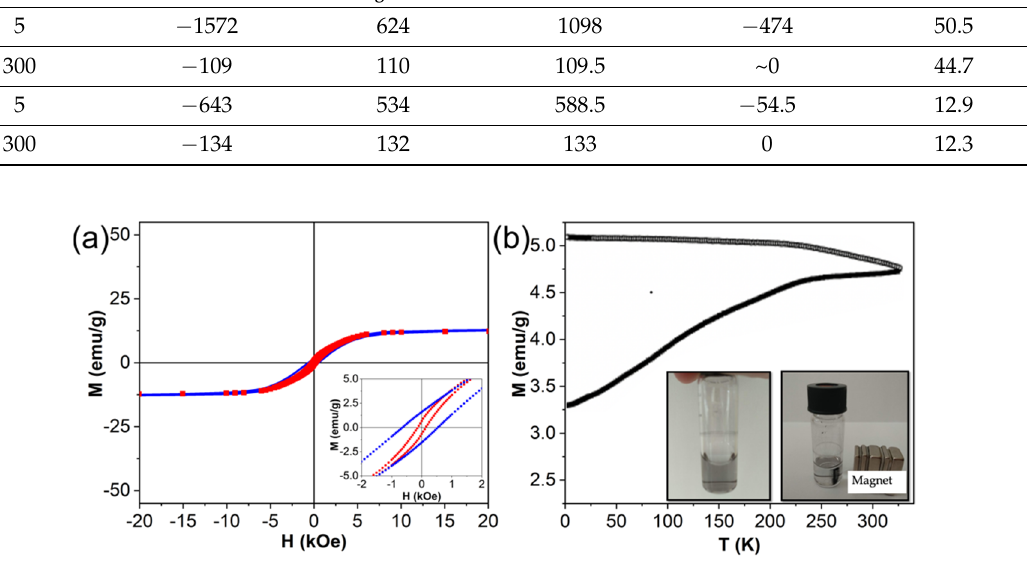
Figure 3. Magnetic characterization of core-satellite Au-Fe NPs. ( a ) Magnetic hysteresis loops measured at 5 K (blue) and 300 K (red). The inset is an expanded view of the low-field region; ( b ) ZFC-FC curves. The inset represents colloidal solutions of the NPs without magnetic field ( left ) and attracted by the magnet ( right ).